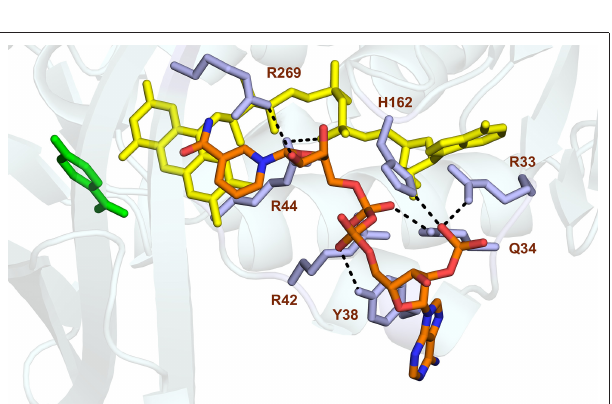
FIGURE 5 | Model of NADPH binding in PHBH Pf . Cartoon image of the PHBH protein chain in light blue, substrate in green, FAD cofactor (in the out position) in yellow and the docked NADPH colored by element. Amino acid residues Arg33, Gln34, Tyr38, Arg42, Arg44, His162, and Arg269, putatively involved in NADPH binding, are shaded in mauve. Hydrogen bonds are indicated by black